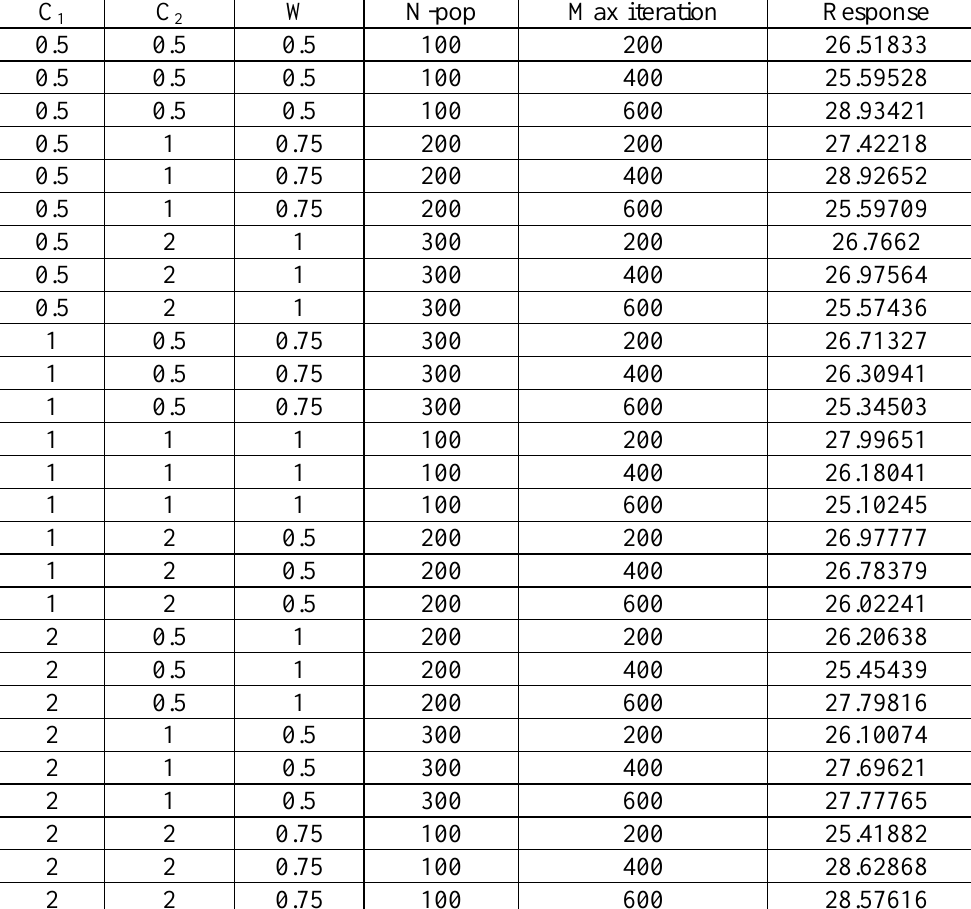
Figure 4. The Signal-to-Noise plots for GA Table 3. The orthogonal array L 27 and results for